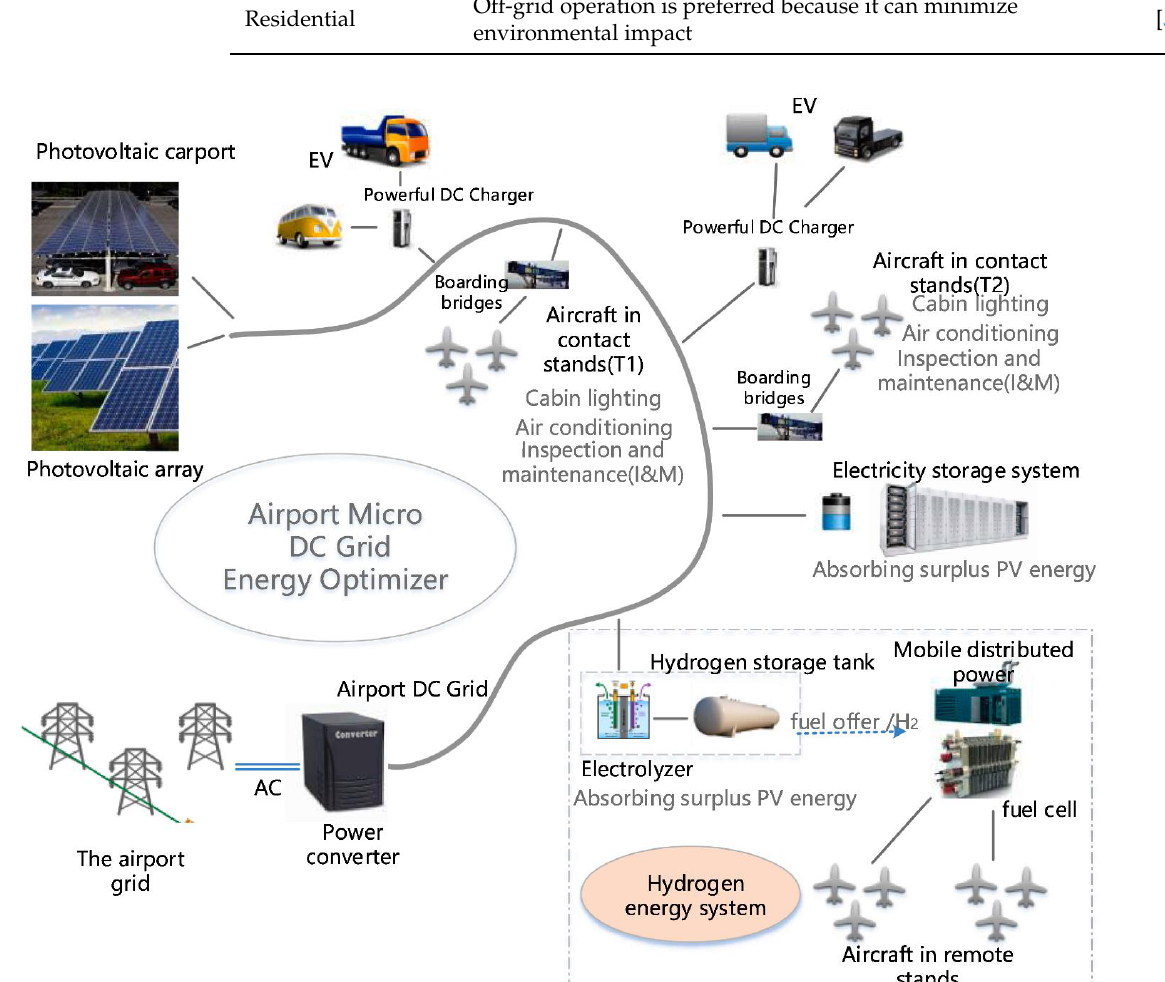
Figure 13. Schematic configuration of a hybrid PV-RHFC microgrid system with battery storage for auxiliary power application for aircrafts and electric vehicles. Reprinted with permission from Ref. [14]. 2021, Elsevier. Table 4. Multipurpose microgrid system applications.